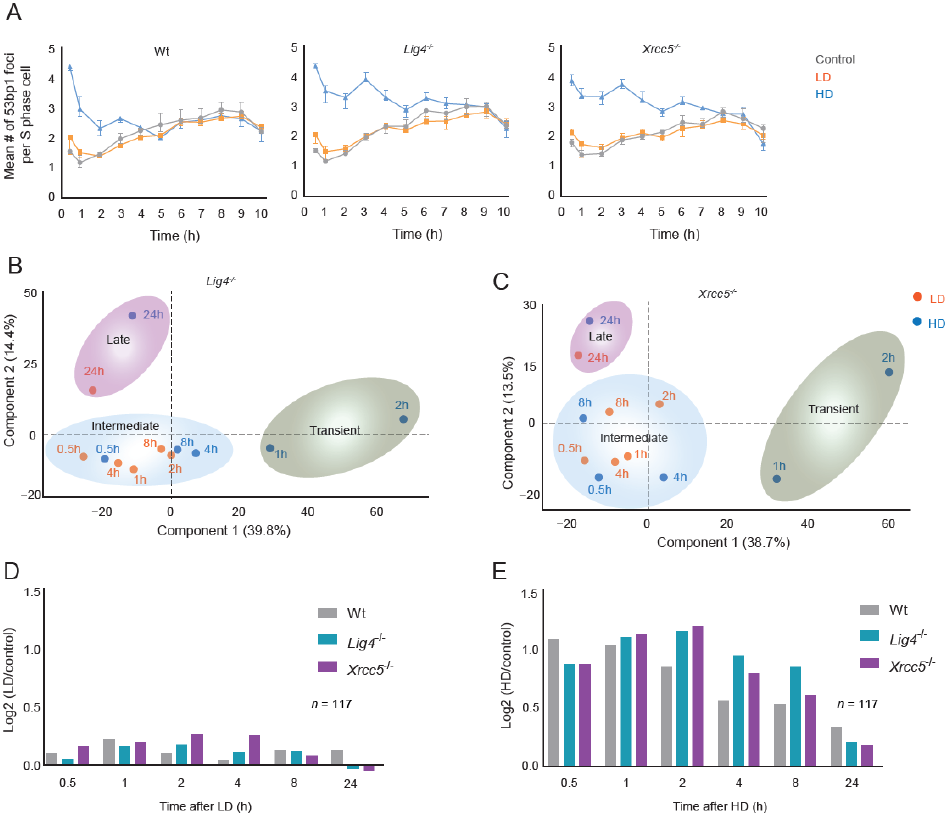
Figure 3. Dynamics of DDR signaling cascades in DSB repair-deficient cells: ( A ) Dynamics of 53BP1 foci decay in wt, Lig4-/- and Xrcc5-/- S-phase cells. Dots and error bars represent the median values of six replicates and 95% CI values, respectively. ( B , C ) PCA maps of log2 SILAC ratios for Lig4-/- and Xrcc5-/- cells. ( D , E ) Bar chart of relative median phosphorylation of cluster A phosphosites after LD and HD in wt and DRD cells.